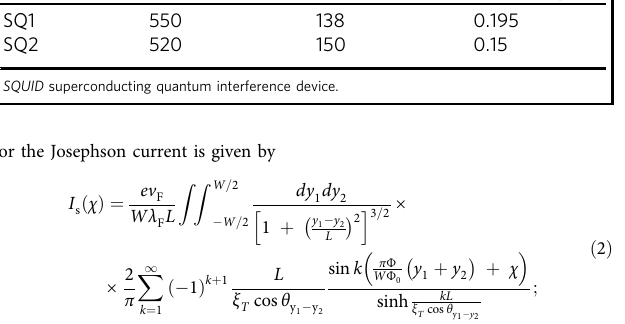
Table 7 Critical current versus temperature (ballistic